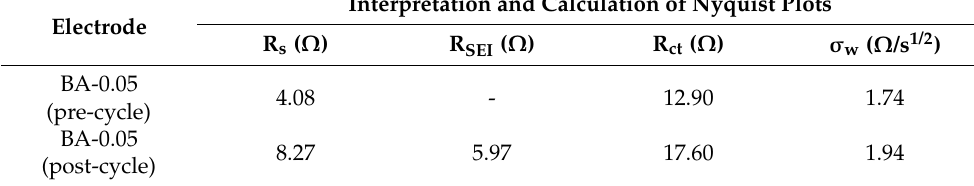
Table 2. Interpretation and calculation of Nyquist plots in prepared BA-0.05 electrode during pre- cycle and